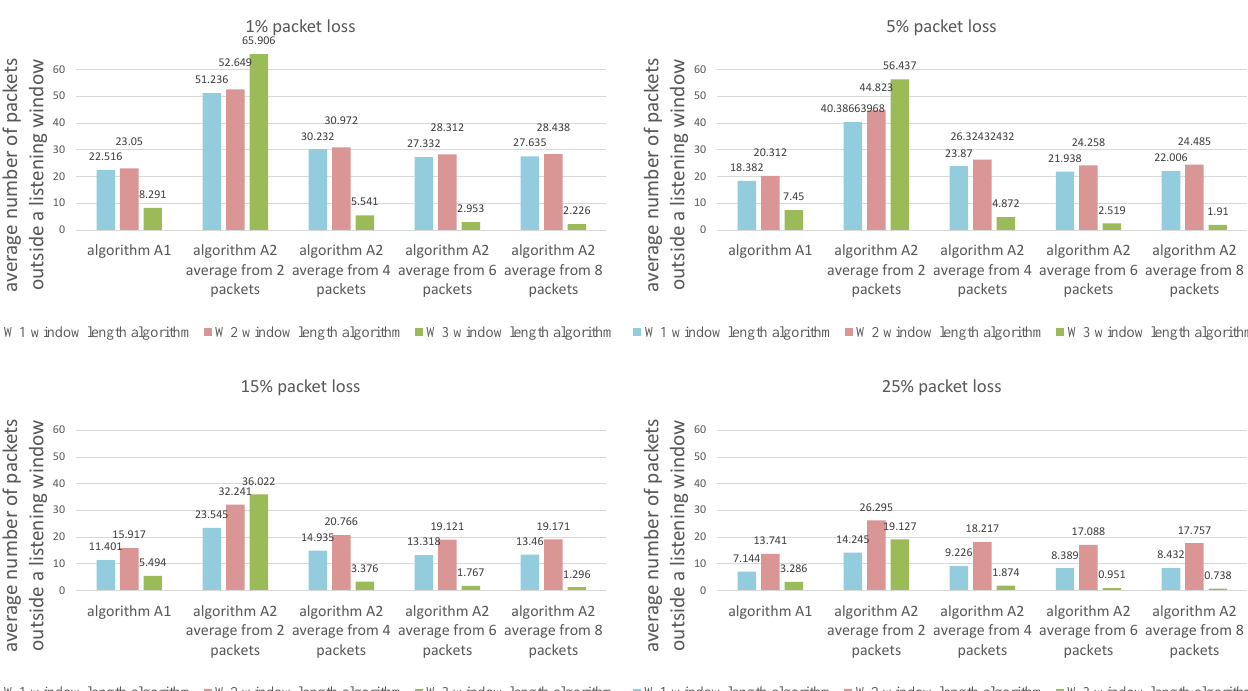
algorithm A2 average from 2 average from 4 packets